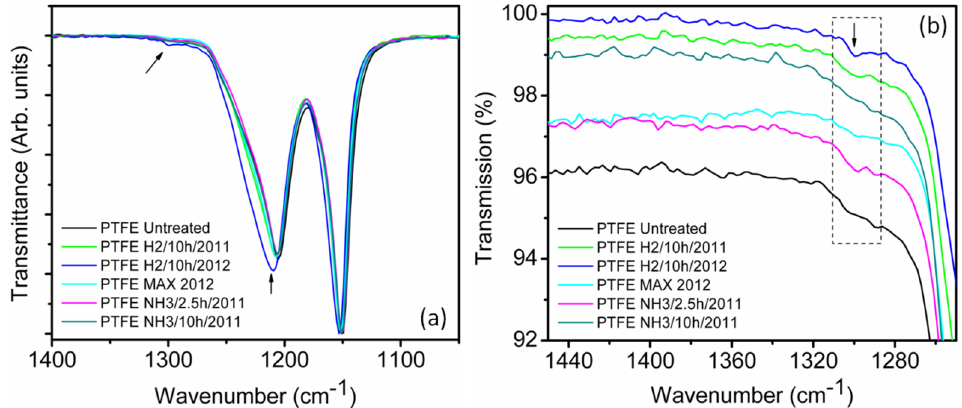
Figure 5. ATR FTIR spectrum of treated and pristine PTFE samples ( a ) In the region between 1250 cm − 1 and 1450 cm − 1 showing the slightly stronger reflection of the bands of PTFE H 2 /10 h and PTFE NH 3 /2.5 h in the vicinity of 1300 cm − 1 . ( b ) in the region between 1050 cm − 1 and 1400 cm − 1 showing the shifted bands of PTFE H 2 /10